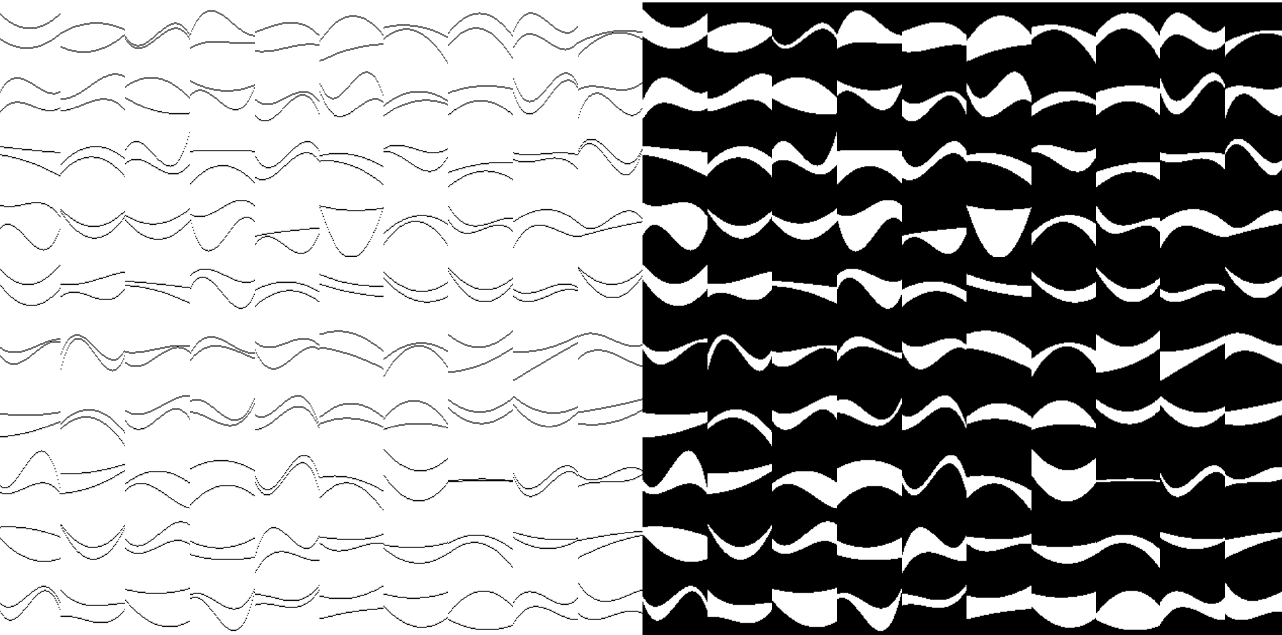
Fig. 2. Part of an artificial dataset of curvilinear meandering regions (grayscale image left and labels right), where the regions are very simple (the stripe can have two bends at the most). The stripes completely separate the upper and lower image parts. Such regions seem quite easy to be segmented (without SSNs). The most instances have pretty thick regions. However, some instances appear as toy dataset artefacts, where the region is either extremely thin (see the third image from the right in the third row from the bottom) or too thick (see the sixth image from the left in the fourth row from the